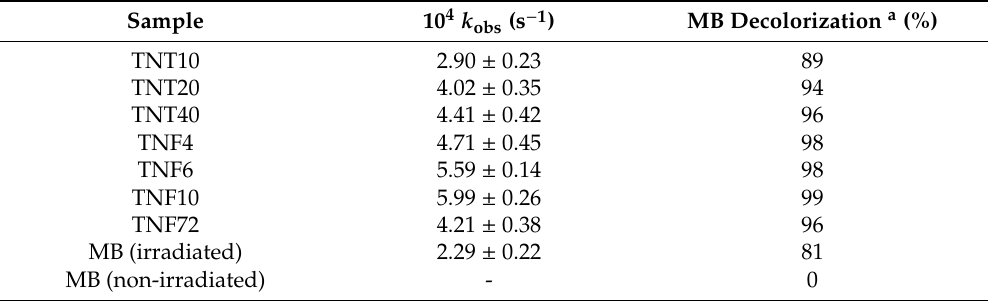
Figure 6. Diffuse reflectance UV-Vis spectra of TNF samples (the left side) and Kubelka–Munk function versus light energy plot for the band gap determination (the right side), ( a ) TNF4–10 and ( b ) TNF72. Table 1. Observed rate constants for MB photodegradation ( k obs ) on TNT and TNF samples, and MB decolorization